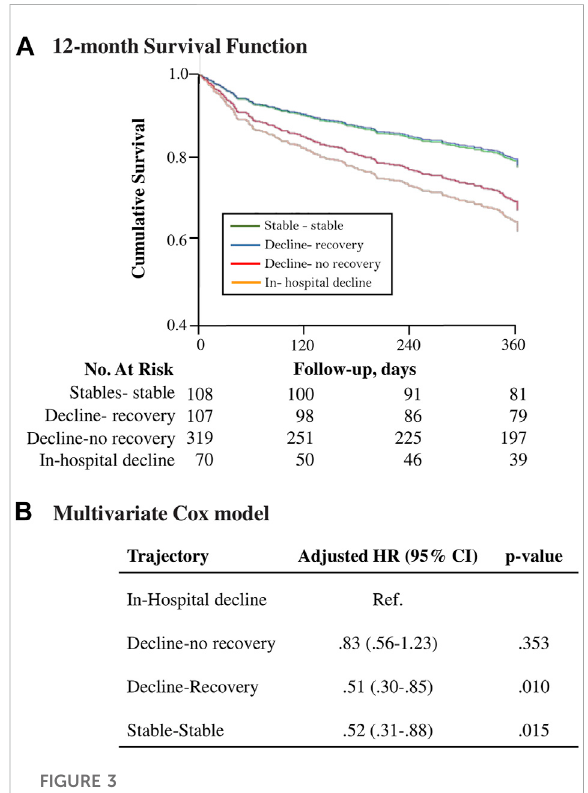
FIGURE 3 (A) Estimated 12-month cumulative survival plot for the 4 functional trajectories, and (B) the adjusted hazard ratios (HR) using the “ in-hospital ” group as the reference category, assessed with multivariate Cox models. Adjusted for age, gender, residence before admission, prior hospital admissions, baseline function, Charlson index, malnutrition, the presence of dementia, and anemia at discharge. Functional status change categories denote prehospital and in-hospital stability ( “ stable-stable ” ), prehospital decline and in-hospital recovery at discharge ( “ decline-recovery ” ), prehospital decline and no recovery at discharge ( “ decline-no recovery ” ), and in-hospital decline, with or without prehospital decline ( “ in-hospital decline ”